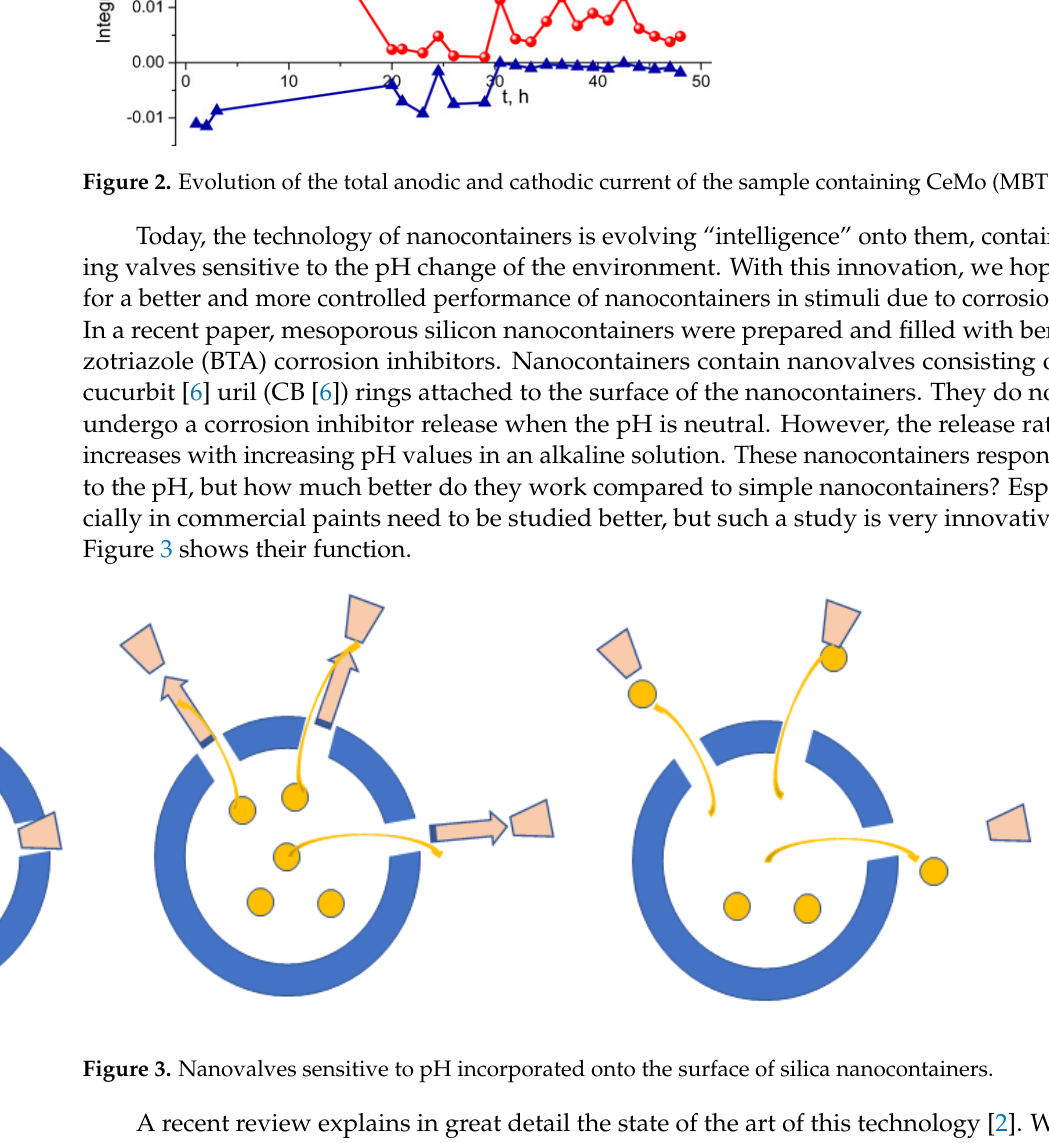
Figure 2. Evolution of the total anodic and cathodic current of the sample containing CeMo(MBT).